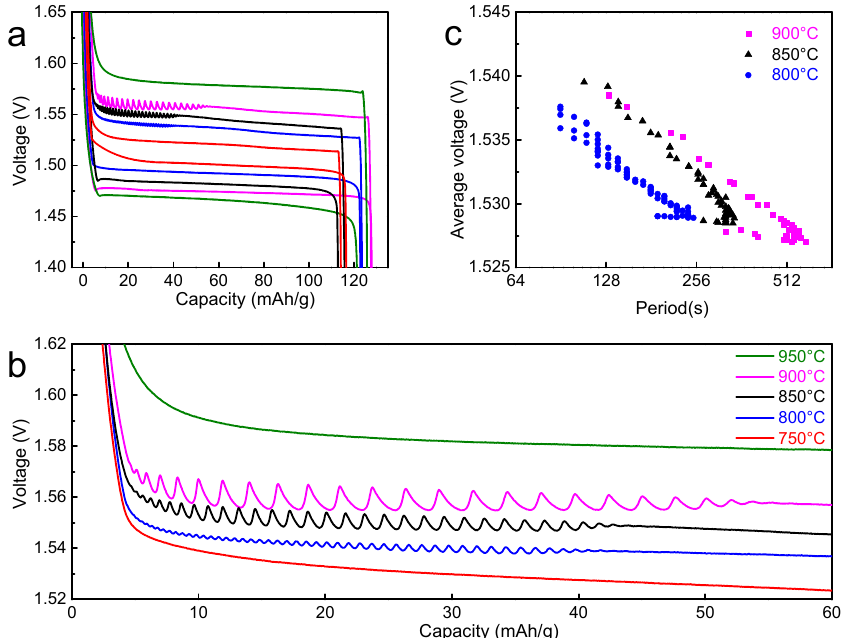
Figure 3. ( a ) The galvanostatic discharge/charge curves of LiCrTiO 4 sintered in a powder form at a temperature of 750, 800, 850, 900 and 950 °C, respectively. ( b ) The enlarged view in the end of charge plateaus. The data are shifted along the vertical axis (750 °C ±0 mV; 800 °C ±10 mV; 850 °C ±20 mV; 900 °C ±30 mV; 950 °C ±40 mV) for viewing convenience. ( c ) The relationship between the period and the average voltage, which were calculated from ( b ).